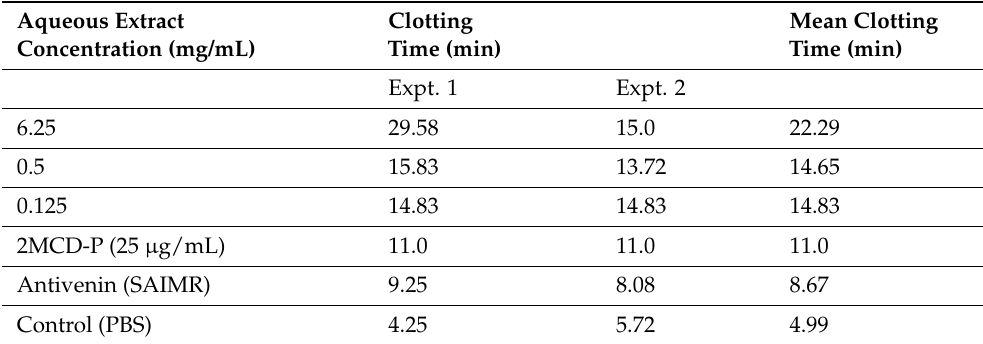
Table 6. Neutralization of coagulation activity of N. melanoleuca venom by aqueous extract and SAIMR polyvenom as